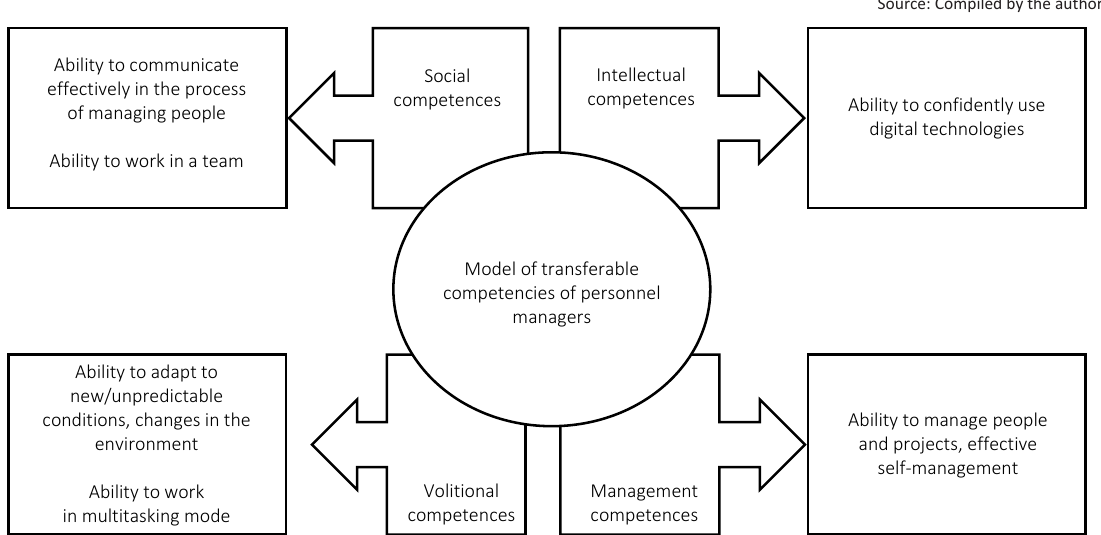
Figure 6. Model of transferable competencies of personnel managers